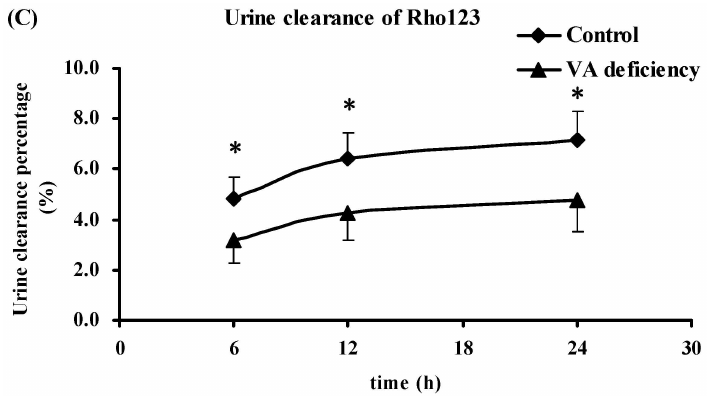
Figure 3. Effects of vitamin A (VA) deficiency on plasma AUC 0 ´ 180min ( A ) and accumulated excretion percentages of Rho123 in biliary excretion ( B ) and urine ( C ). Biliary excretion and urinary excretion of Rho123 were used to investigate the functional activities of P-GP in liver and kidney, and the plasma AUC 0 ´ 180min was also estimated. Each datum represents the mean ˘ SD of five rats. * p < 0.05 vs . the control values using ANOVA statistics followed by the Student–Newman–Keuls multiple comparison post hoc test.